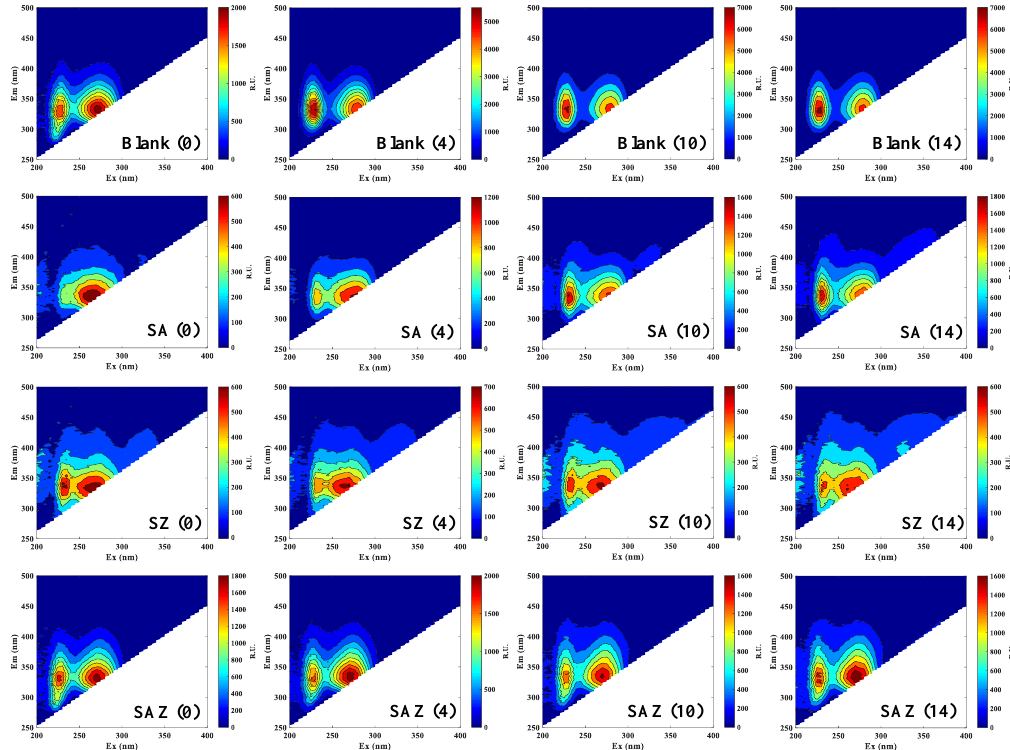
Figure 3. EEMs of DOM fluorescence for S. dohrnii with different treatment at four time point. Note that different color bars are used for each group (Raman units, R.U.). Blank, S. dohrnii -only; SA, with penicillin for S. dohrnii ; SZ, with Zn 2+ for S. dohrnii ; SAZ, with penicillin and Zn 2+ for S. dohrnii . (0), (4), (10), and (14) are represented as 0, 4, 10, and 14 days, re- spectively.